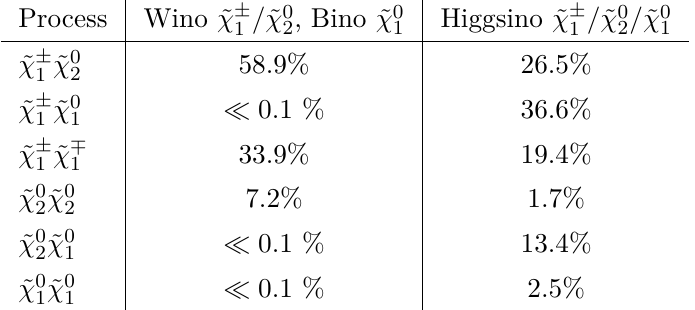
) = 100 GeV and m (˜ χ 0 ) = 95 2 1